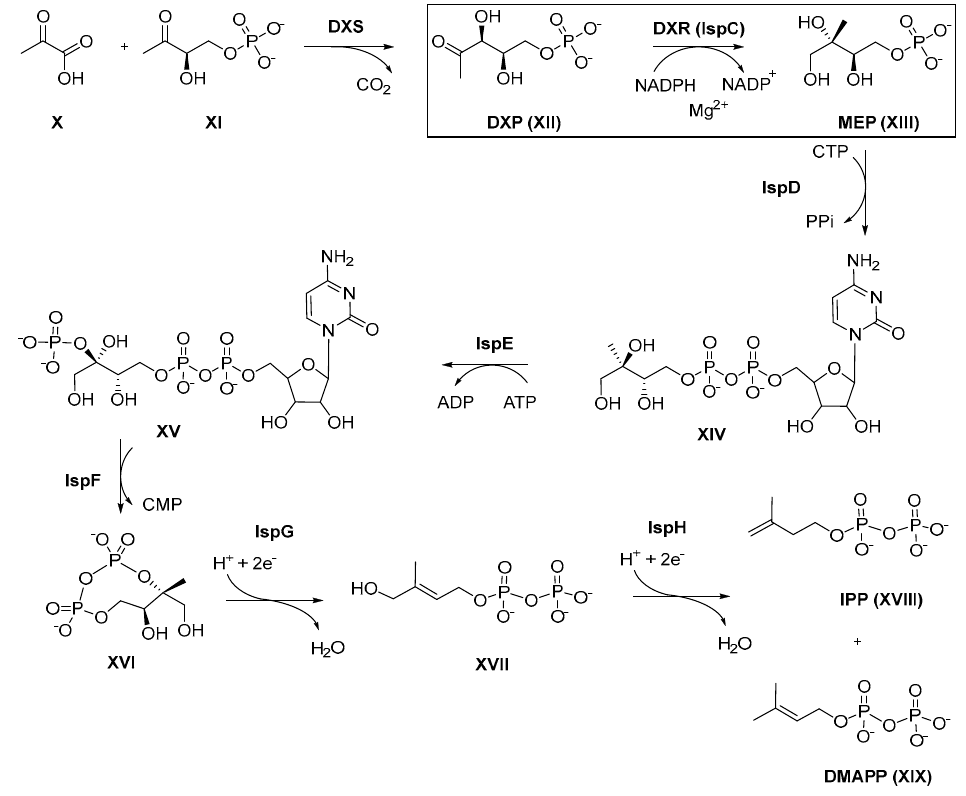
Figure 4. The MEP pathway leading to the isoprenoid precursors isopentenyl diphosphate ( XVII, IPP ) and dimethylallyl diphosphate ( XIX, DMAPP ) via an IspC/DXR-catalysed conversion of 1- deoxy- D -xylulose 5-phosphate (X II, DXP ) to 2-C-methyl- D -erythritol 4-phosphate ( XIII, MEP